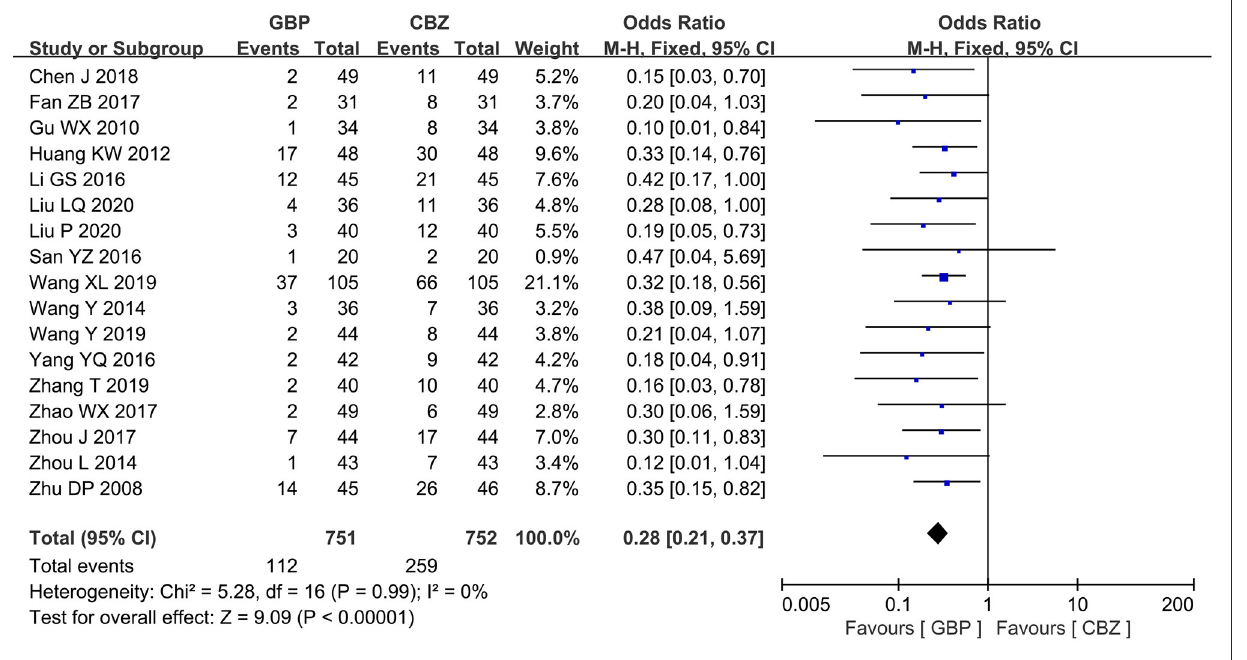
the control group. The sample size was between 40 and 210, the treatment time ranged from 28 days to 60 days, and the studies were published between 2008 and